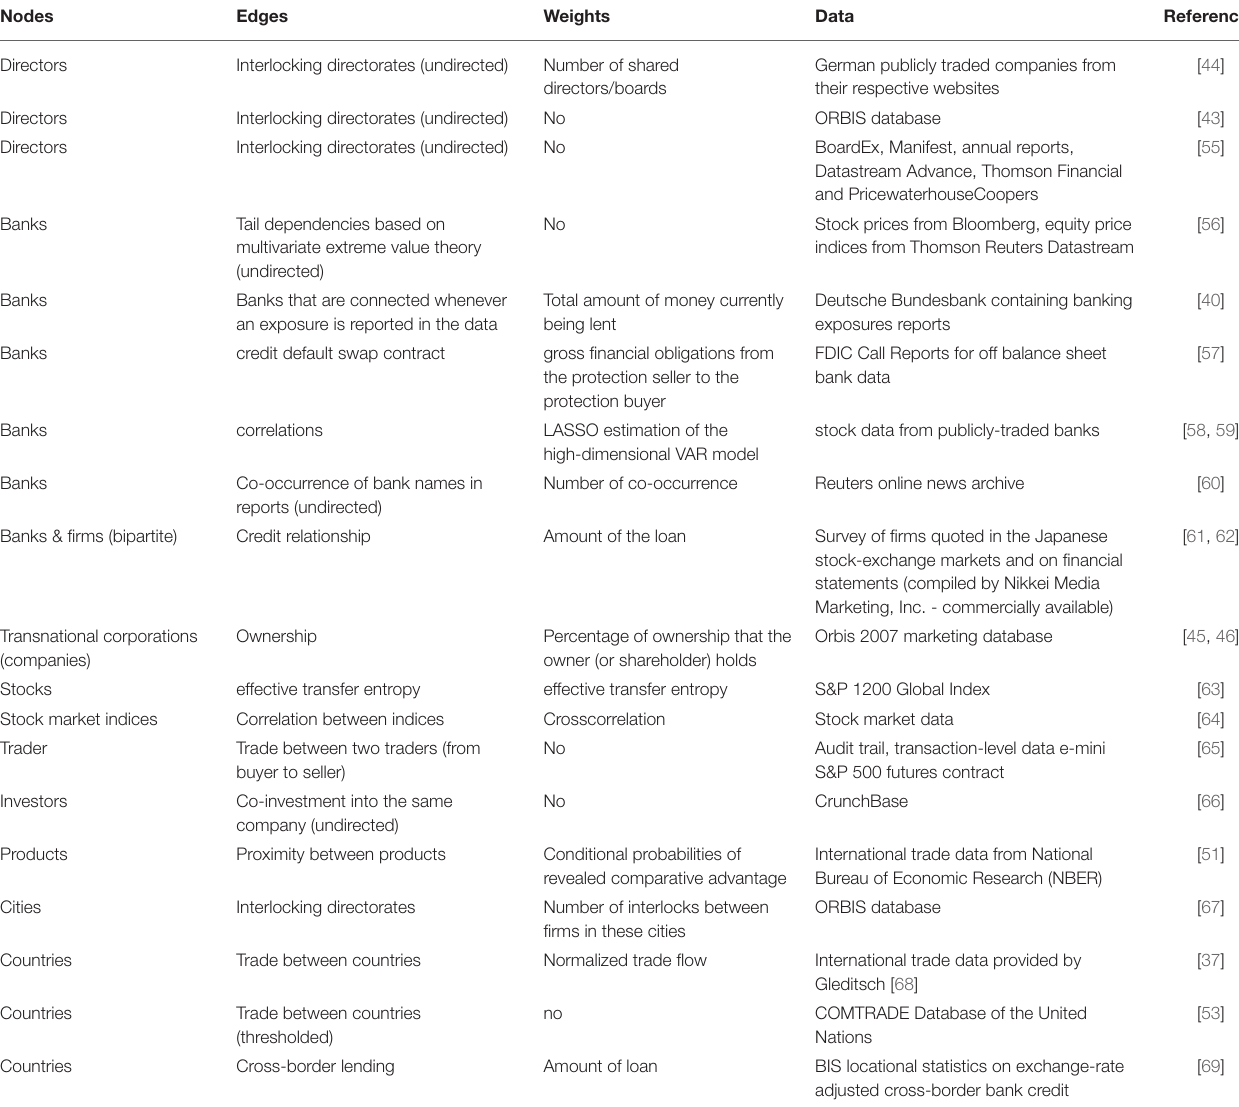
TABLE 2 | An overview of studies investigating different types of global economic networks.